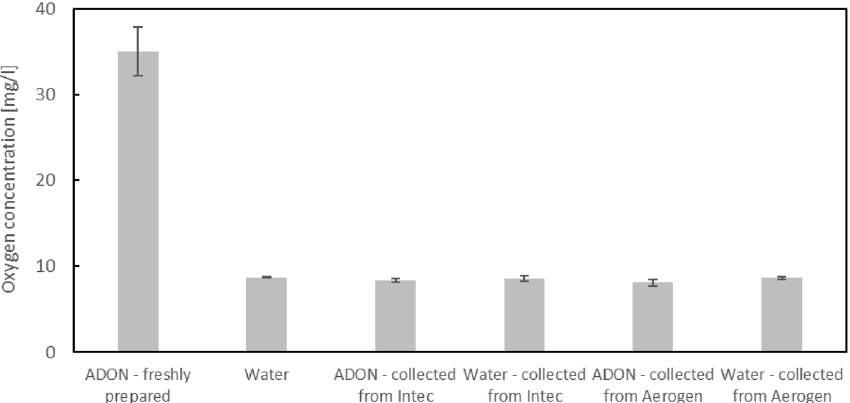
Figure 5. Oxygen concentration in water and ADON directly after generation and in the samples condensed after nebulization. Mean values (n = 3) + standard deviation (error bars). There is no statistically significant